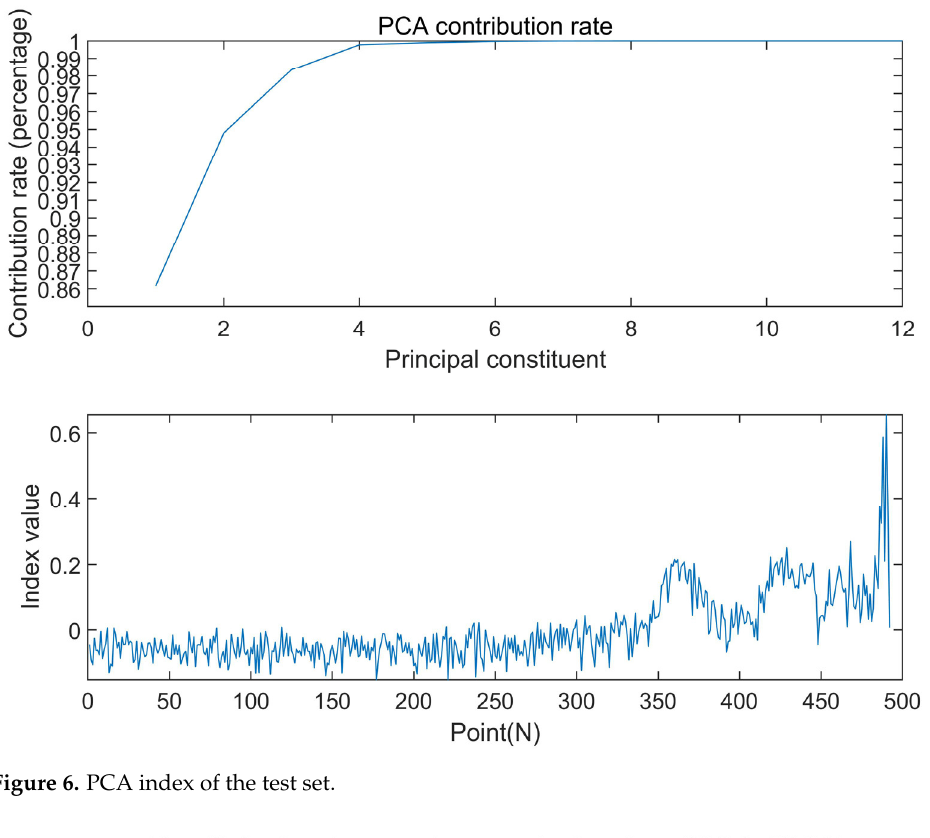
Figure 6. PCA index of the test set.